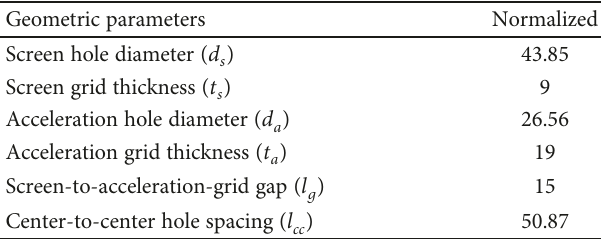
Figure 2: The CEX ion generation region division. Table 1: Normalized geometric parameters [12].